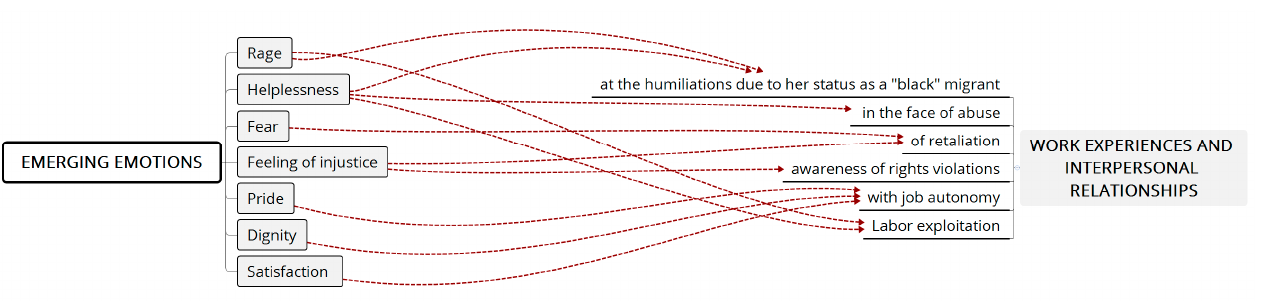
Figure 5. Emerging emotions. Source: Own elaboration.